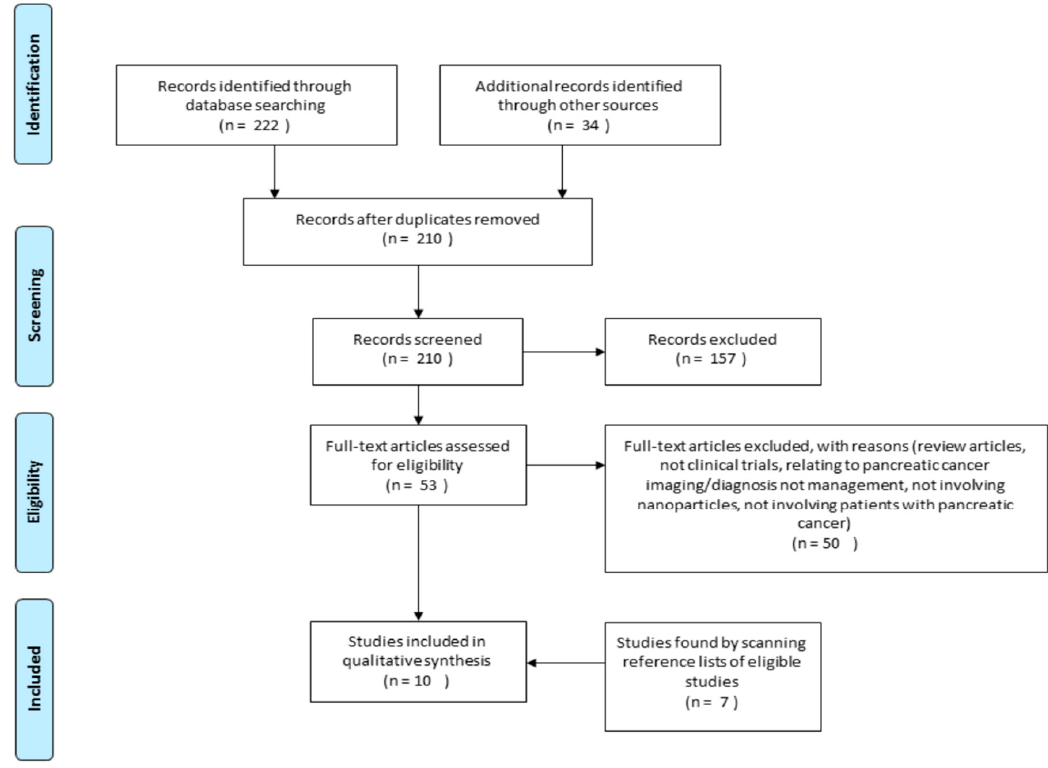
Figure 1. Flow diagram illustrating data collection protocol employed in this study.